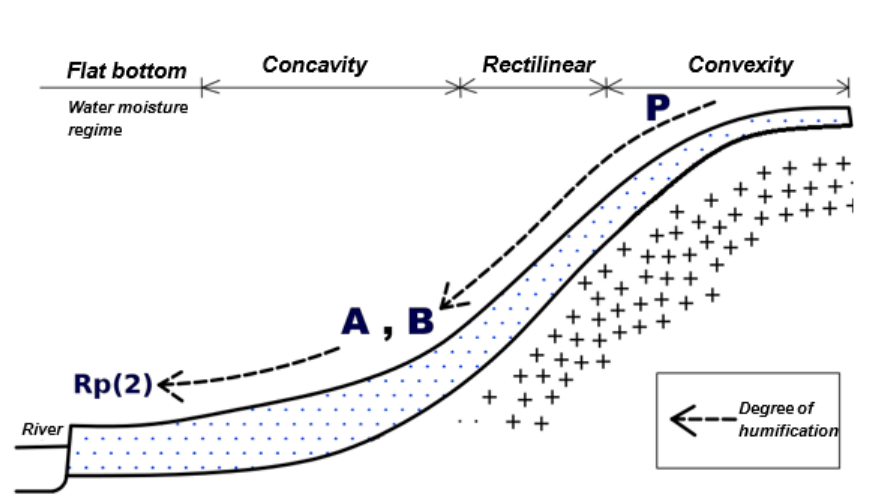
Note: ns: Not Significant. *p < 0.05